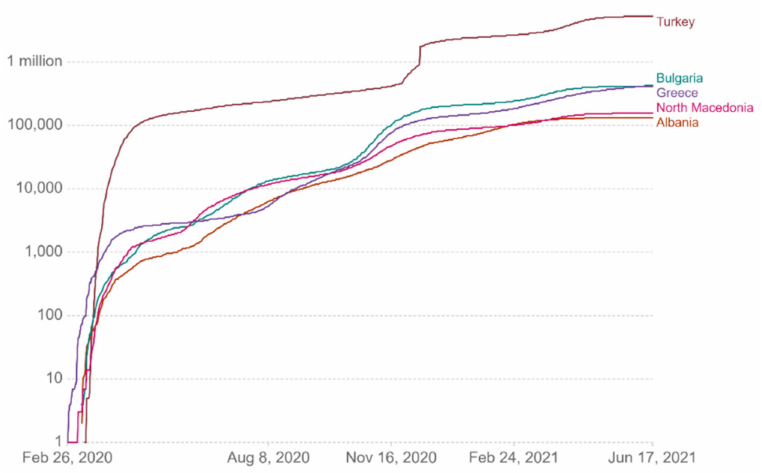
Figure 8. Cumulative confirmed cases per